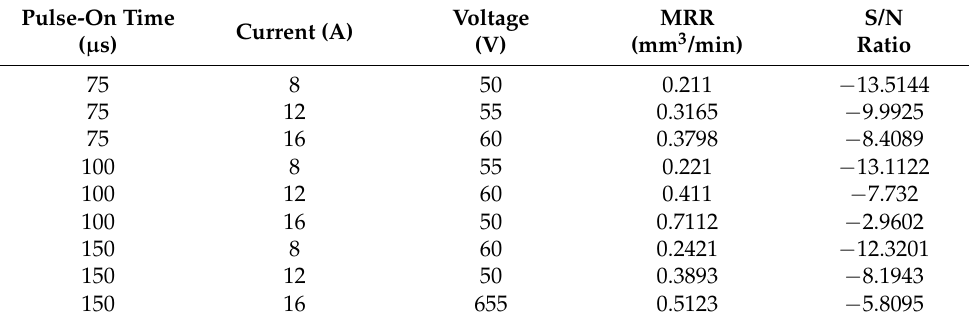
Table 10. Response for the ‘larger-the-better’ S/N ratio.